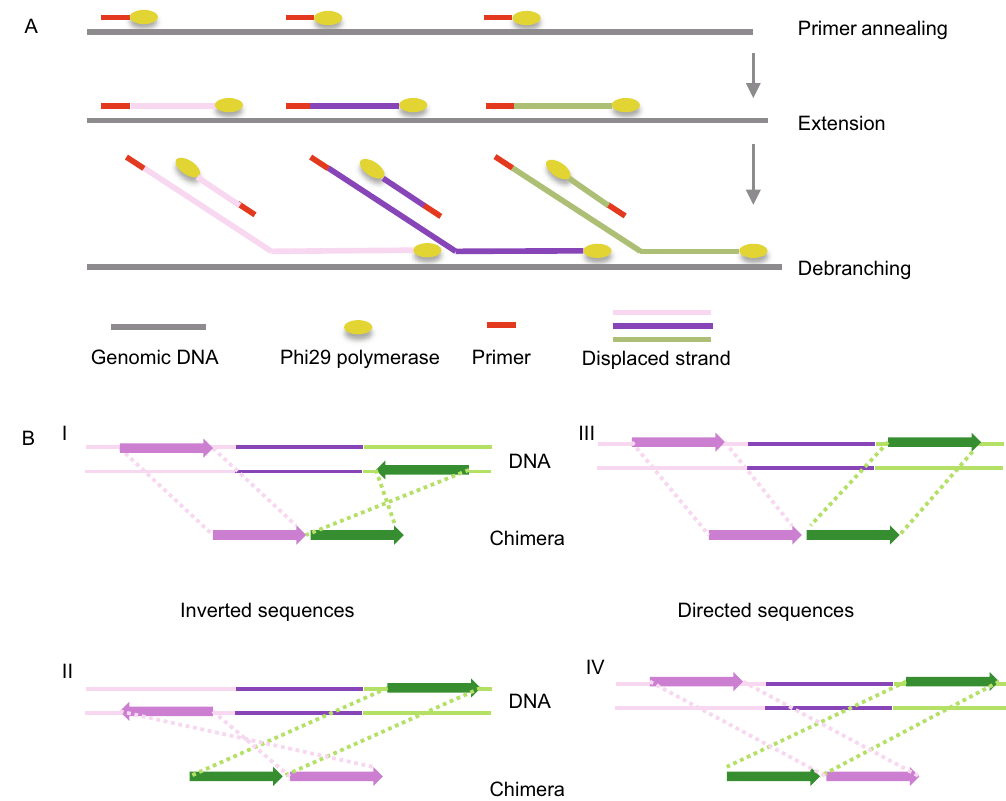
Figure 2. Multiple displacement ampli fi cation process and chimera types. (A) Primer annealing to the DNA and extension by Phi29 DNA polymerase. Phi29 DNA polymerase can displace downstream 5 ′ -termini DNA strand to extend the growing 3 ′ -termini strand by a simple branch migration reaction, and 3 ′ -termini can be displaced as well in a similar way. (B) Four types of chimeric rearrangements. I: the second segment is inverted from its original orientation and directly joined after the fi rst segment. II: the second segment is inverted from its original orientation and directly joined before the fi rst segment. III: two directed segments are directly joined. IV: two directed segments are reversely